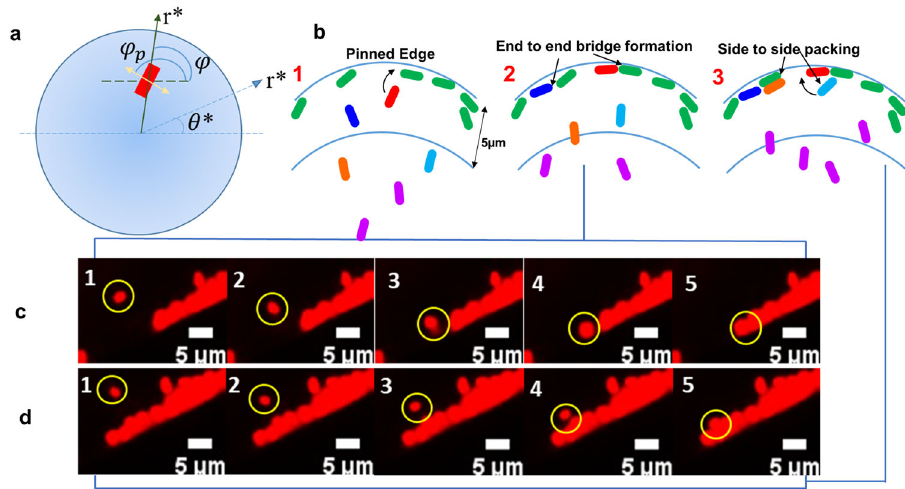
Fig. 7 Model C Schematics and live Cell Images. a Schematic of the top view of the droplet with polar coordinates ( r *, θ * ) and of the particle-induced deformation, approximated as a quadrupole. The angle ϕ p indicates the orientation of the quadrupolar rise axis, represented as a two-headed arrow. The angle ϕ indicates the orientation of the principal axis of curvature. b Schematic representation of Model C depicting bacterial orientation and packing having end-to-end and side-to side attraction. c , d Sequence of live cell images depicting bacterial end-to-end and side-to side attraction where, ( b(2) ) and ( b(3) ) are the schematics that represents ( c ) and ( d ), respectively. Bacterial orientation starts from 5 μ m